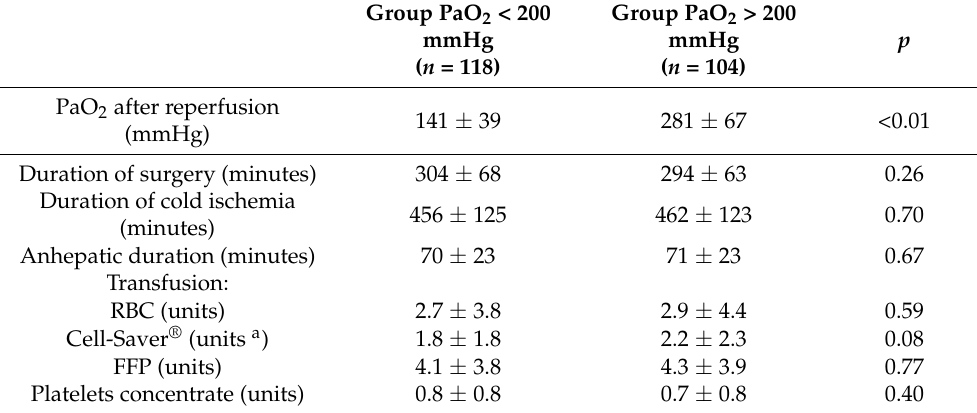
Table 3. Intraoperative data.